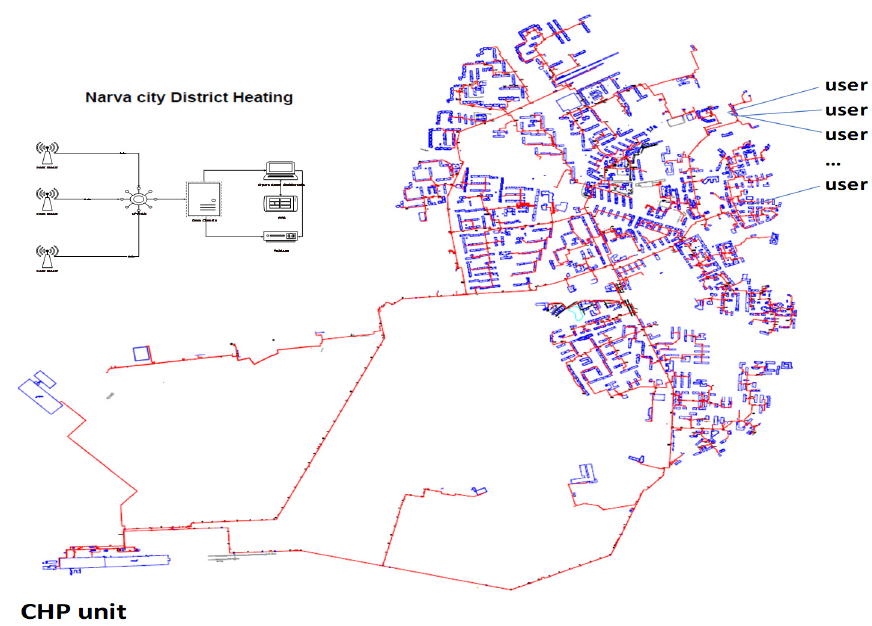
Figure 1. Narva district heating network.